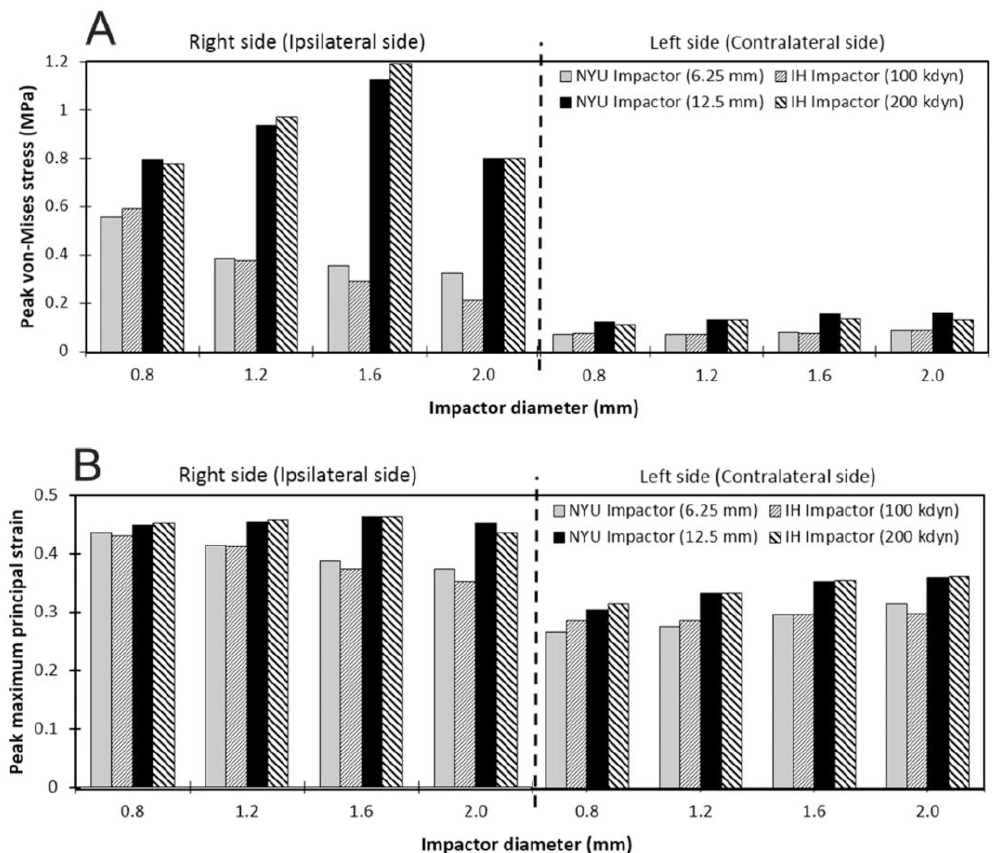
Figure 3. ( A ) Peak von-Mises stress and ( B ) maximum principal strain in the right and left side of the spinal cord for the New York University (NYU) and Infinite Horizon (IH) impactors at impactor tip diameters of 0.8 mm, 1.2 mm, 1.6 mm, and 2.0 mm.